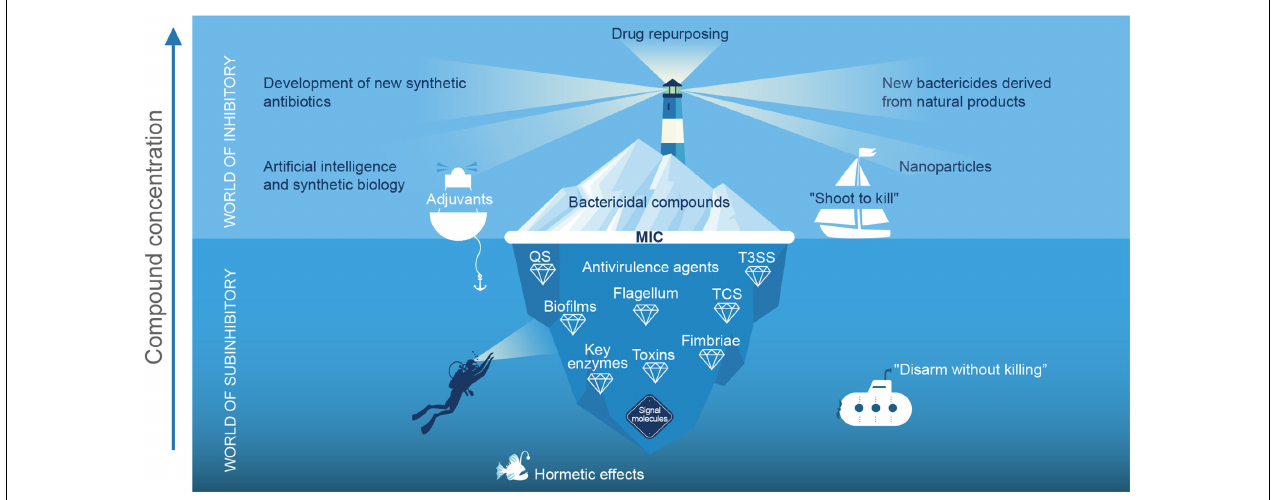
FIGURE 1 | Schematic representation of the current status of antimicrobial strategies: “The world of the inhibitory”. The tip of the iceberg represents the bactericidal compounds that have been discovered, while the light of the beacon searches for current strategies to prevent the “dusk” of this class of molecules. The resurgence of research in natural products, repurposing drugs for use as antibiotics, nanoparticles, chemical synthesis of new bactericides, as well as advances in computer science, omics, artificial intelligence, and synthetic biology are playing a relevant role in the development of new bactericidal compounds (Zakeri and Lu, 2013; Pushpakom et al., 2018; Li et al., 2019; Stokes et al., 2020). However, in this analogy the strategy of “shooting to kill,” allows some pathogenic microorganisms to live and generate resistance; in addition, in the “crossfire” beneficial microorganisms are eliminated. In the “world of the sub-inhibitor,” the number of bioactive molecules to be explored is greater, and the strategy is based on “disarming without killing,” in theory, will not induce resistance. At values below the minimum inhibitory concentration (MIC), the compounds exhibit different effects, among which are anti-virulence, and signal molecule activity, and they have hormetic and adjuvant effects (Cox et al., 2017). The term “anti-virulence agent” also includes peptides, enzymes, and antibodies. QS, quorum sensing; TS33, type 3 secretion system and TCS, two-component